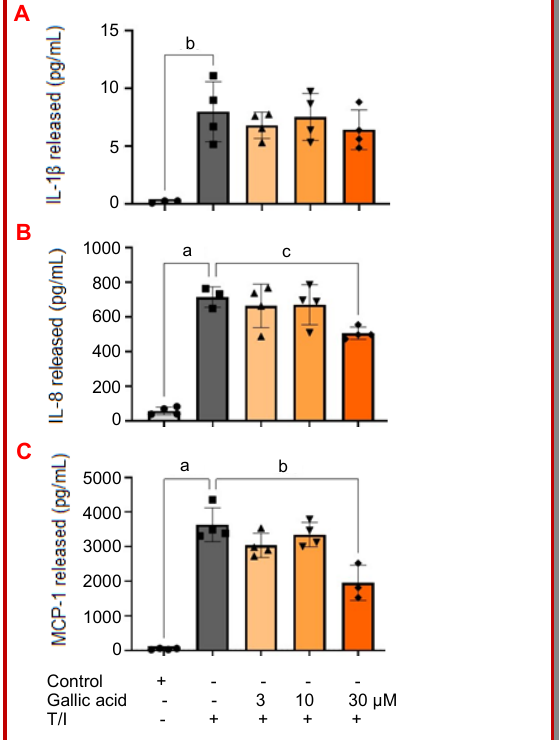
Figure 2: Effects of gallic acid on cytokine and chemokine release in HaCaT keratinocytes. HaCaT cells were treated without (control) and with different concentrations of gallic acid in the presence of 10 ng/mL recombinant human TNF- α and 10 ng/mL IFN- γ (T/I) for 24 hours. IL-1 β, IL-8, and MCP- 1 in the culture media were detected using ELISA. Data are presented as a percentage of control group values (mean ± SD of three to six independent experiments). a p<0.0001, b p<0.001, and c p<0.05 indicate a significant